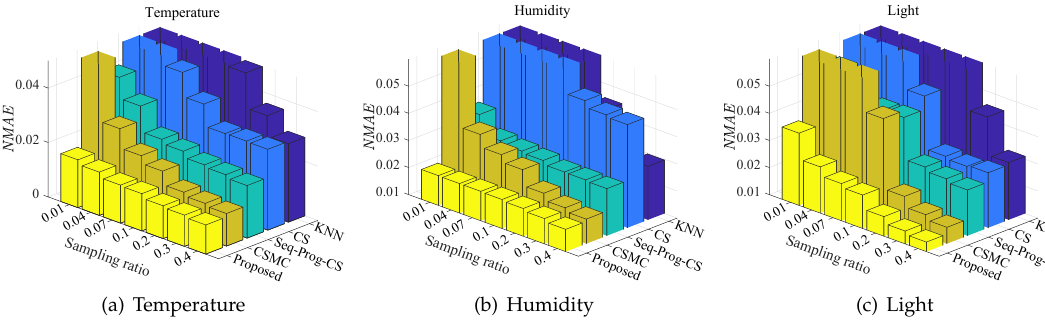
Figure 3. The recovery performance of KNN, CS, Seq-Prog-CS, CSMC, and the proposed method for three attributes in GreenOrbs : ( a ) temperature, ( b ) humidity, and ( c )